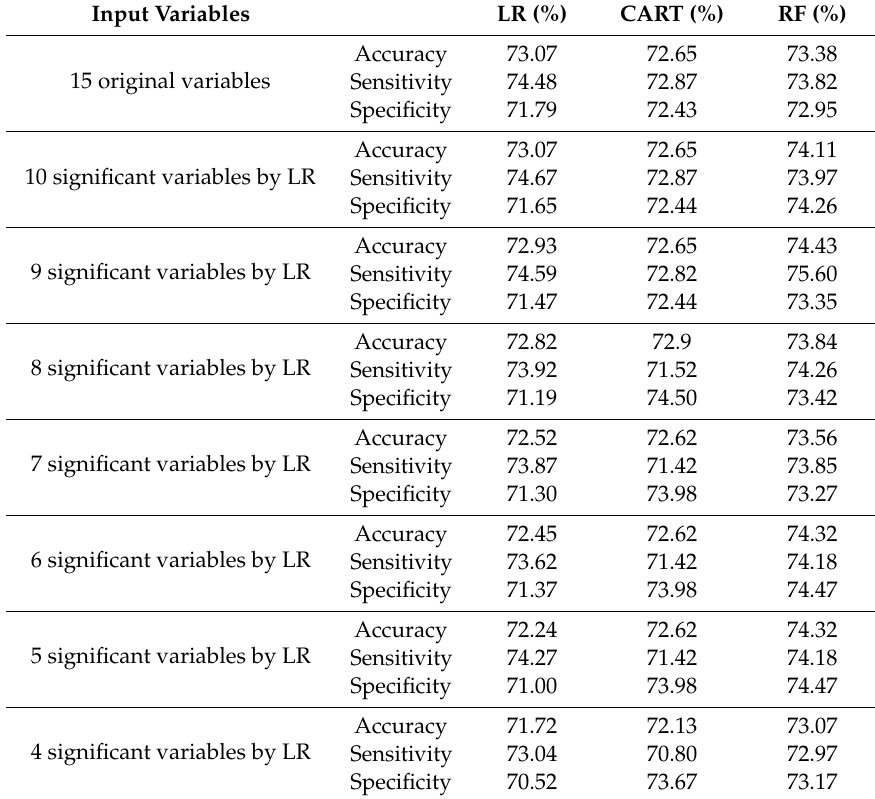
Table 5. Accuracy, sensitivity and specificity of LR, CART and RF with input of significant variables identified by